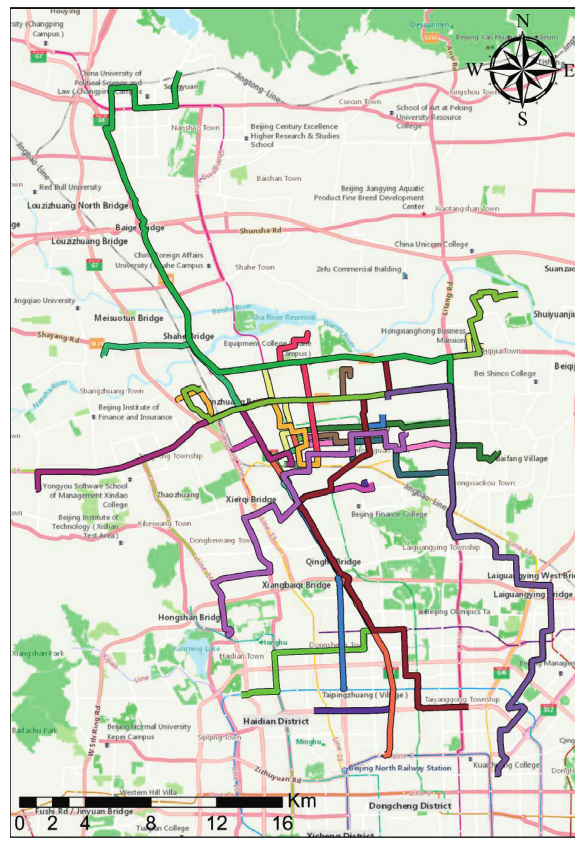
Figure 5: Huilongguan town and bus routes.